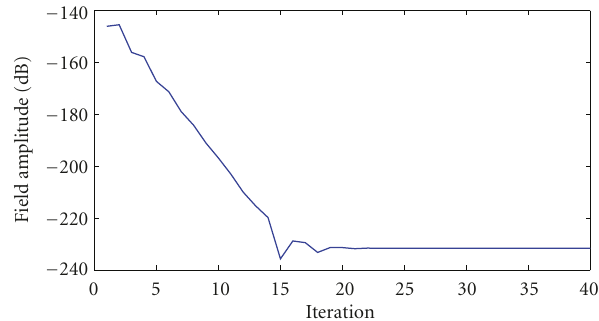
Figure 3: Convergence of the iterative approximation of line source in vertical polarizationwith k z = 0, I z = 1 × 10 − 10 A at 2.45GHz, the source position: ρ s = 15cm, φ s = 90 ◦ , and the observation position: ρ = 15cm, φ = 270 ◦